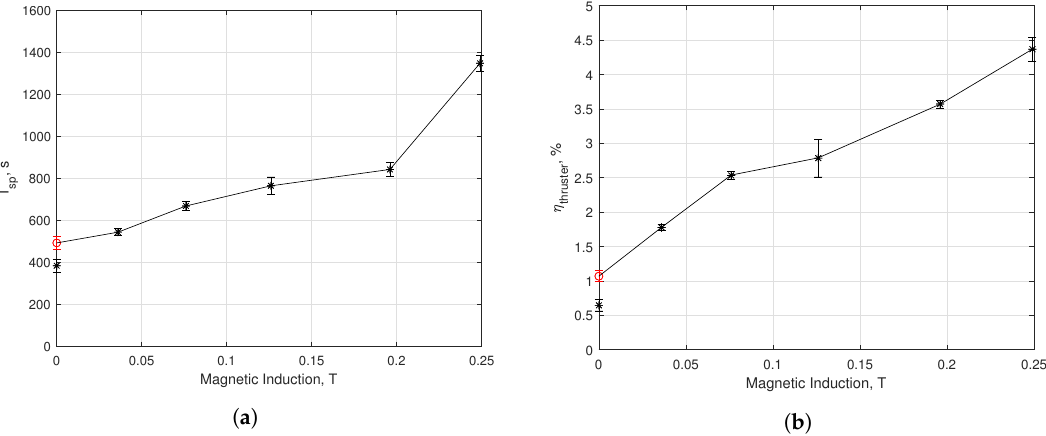
Figure 14. Thruster I sp ( a ) and efficiency ( b ) versus magnetic induction. B = 0 “no coil” results are indicated in